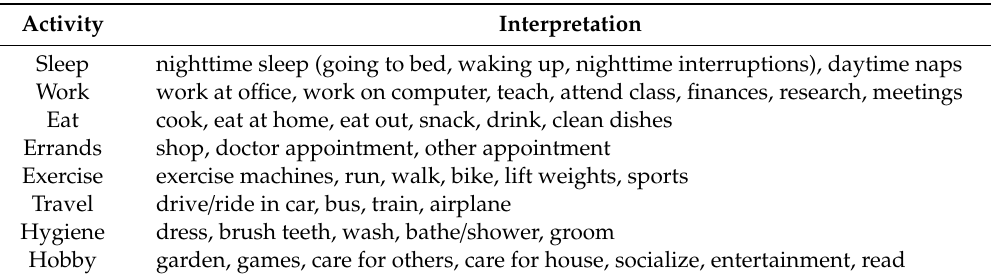
Figure 4. A one-day sequence of activities and corresponding activity durations for one of the users. Time on the x axis starts and ends at midnight. Table 1. Activity categories.